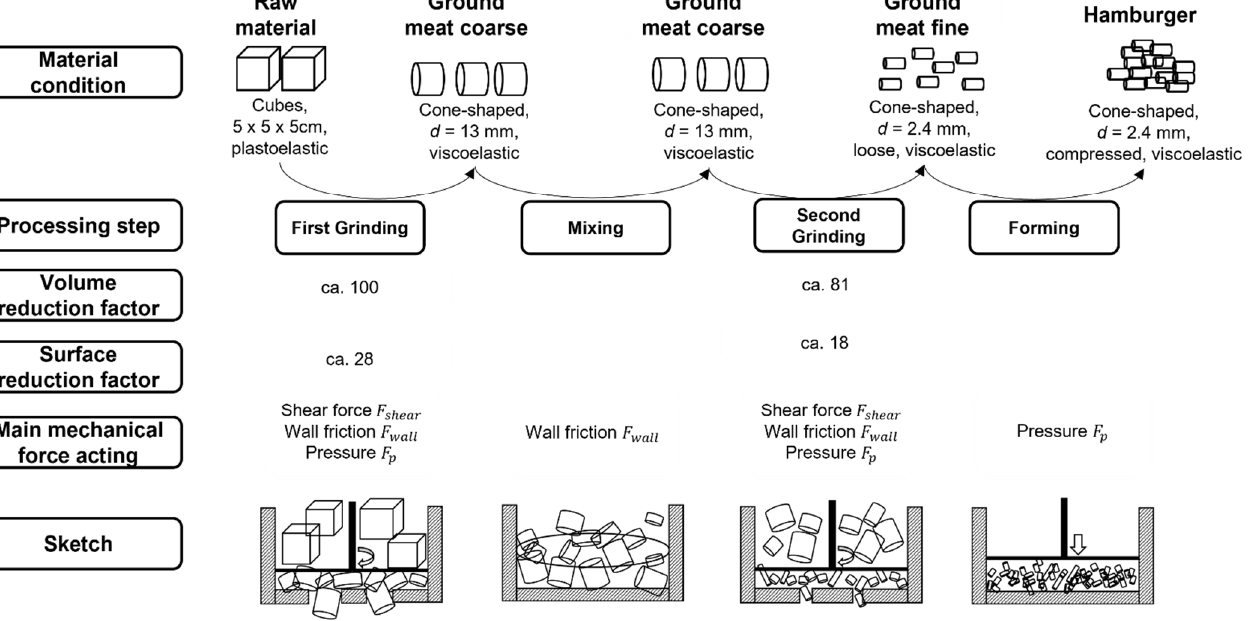
Figure 5. Changes in material conditions and main mechanical forces in meat upon hamburger man- ufacturing.